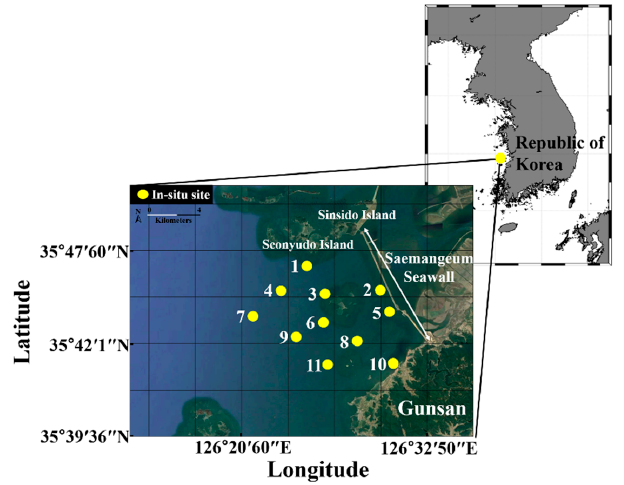
Figure 1. Location of the Saemangeum seawall (study area) off the western sea of the Korean peninsula.